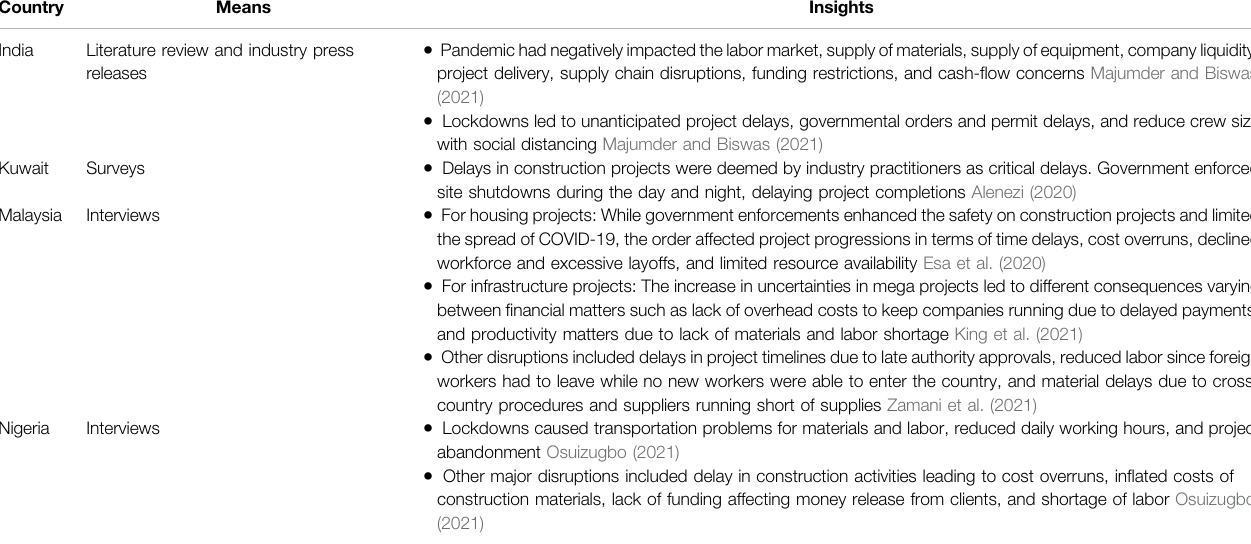
TABLE 1 | Selected studies on the impact of the COVID-19 pandemic on regional construction industries. Country Means Insights Literature review and industry press